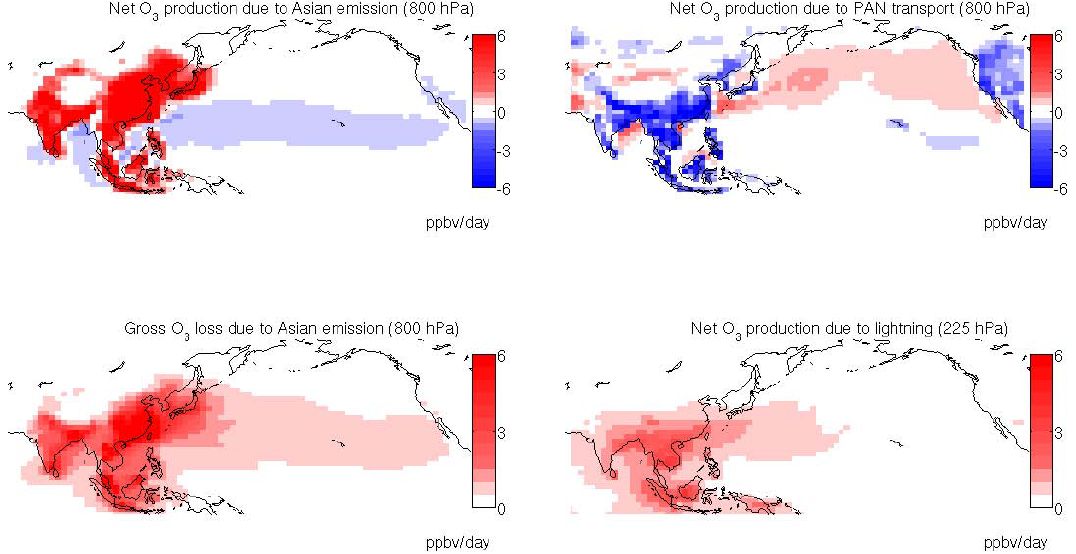
Fig. 11. Model studies of O 3 production in spring 2006. Net O 3 production at 2km due to Asian anthropogenic emissions is shown on the top left, while net O 3 production due to PAN transport at 2km is displayed in the top right. The bottom left panel shows the gross loss of O 3 due to Asian anthropogenic emissions at 2km. The bottom right panel displays net O 3 production due to the lightning NO x source at